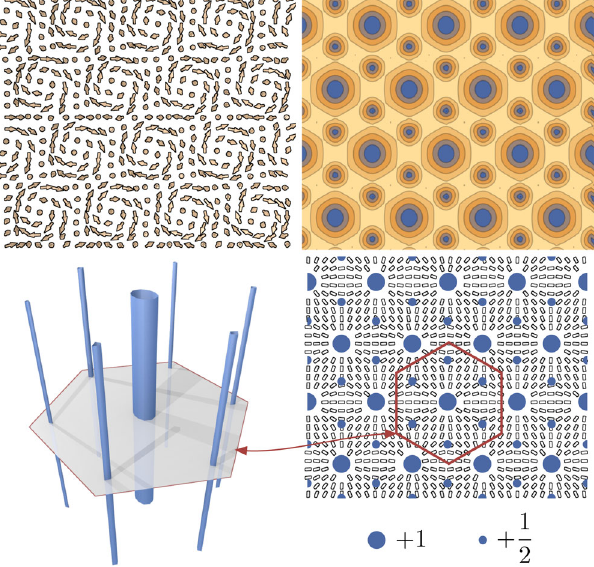
FIG. 2. Skyrmion lattice. Each unit cell possesses a single central s ¼ 2 umbilic, with the six outer s ¼ 1 umbilics each shared between three unit cells giving a total count of 2 þ 6 × 1 = 3 ¼ 4 umbilics ¼ 1 Skyrmion per unit cell. Top left: Unit vector field n in a Skyrmion lattice. Top right: Contour plot of j Δ j showing the umbilic lines forming a lattice of tubes. Bottom right: Eigenvector field of Π , illustrating the þ 1 winding around the central umbilics and − 1 = 2 winding around the outer umbilics. Note that both are counted with the same sign as the orientation of n changes from one to another. Bottom left: Umbilics form lines in three